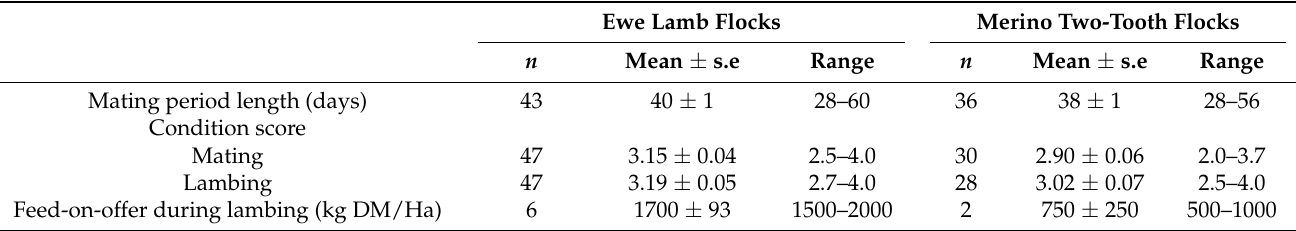
Table 3. Characteristics for management of maiden ewes based on eligible survey